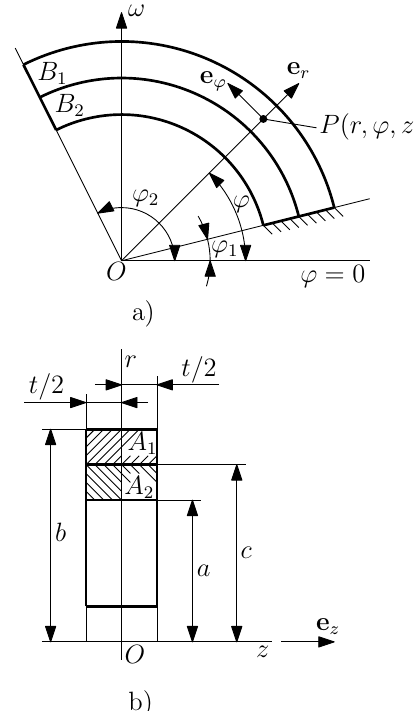
Figure 1: Rotating two-layer curved beam (a) and its cross section